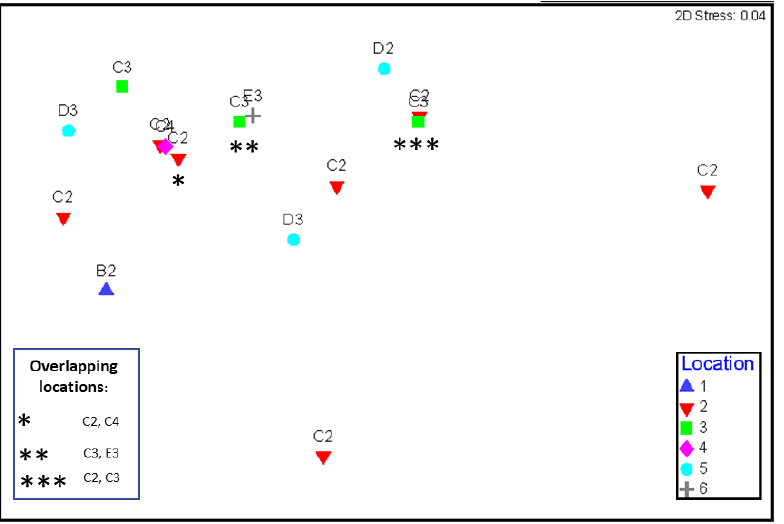
Figure 6. Non-metric multidimensional scaling (NMDS) comparing sightings-per-unit-effort (SPUE) of shark sightings (total assemblage) among locations (see Figure 1 for grid cell locations). Dangerous sharks [34] comprised 12% of all sharks sighted with one G. cuvier and forty two C. leucas were reported, and no C. carcharias were recorded in our study.